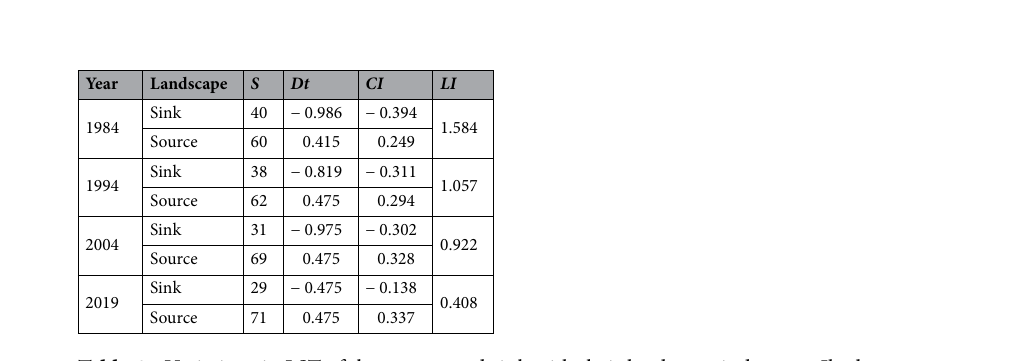
Table 4. Variations in LST of the source and sink with their landscape index over Ibadan.